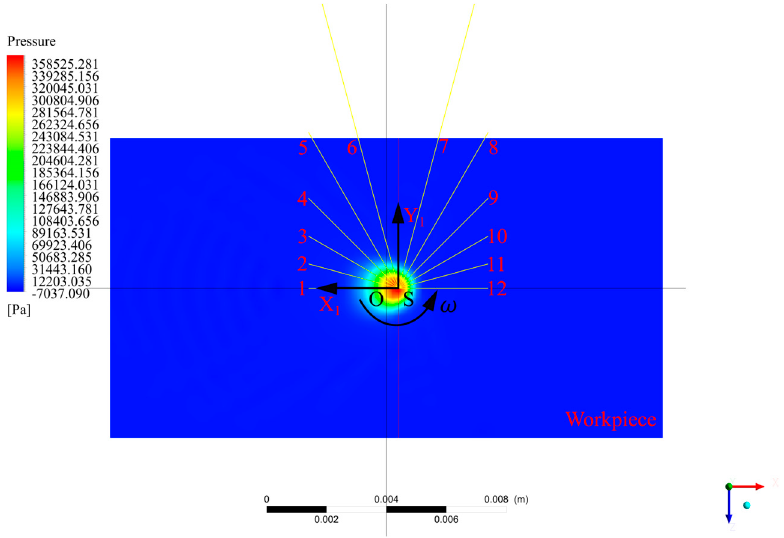
Figure 4. A pressure cloud diagram of a workpiece surface.